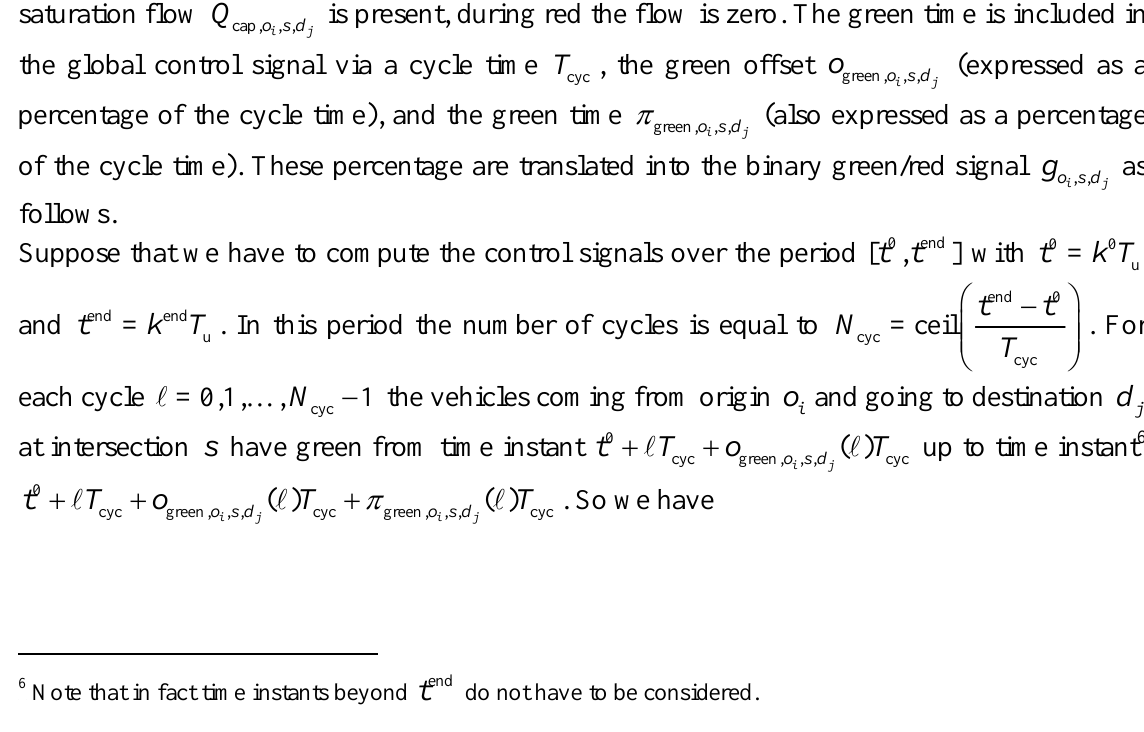
Figure 7. MPC-based control implemented with local controllers The traffic signals work as given in (6). During the green time (i.e.